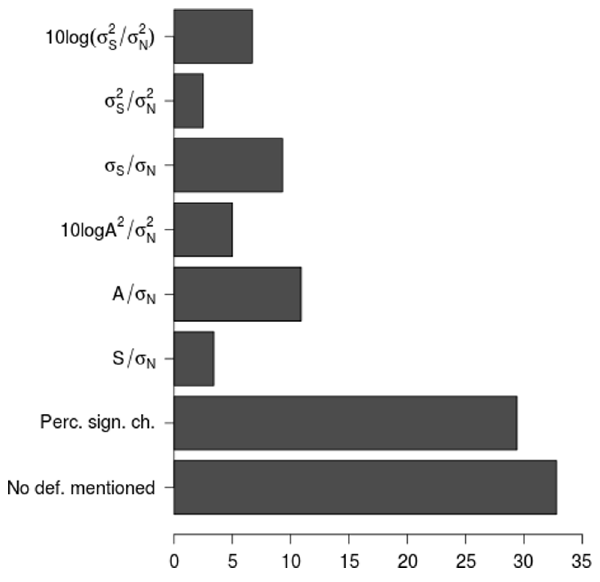
Figure 3. Percentage of the 119 simulation studies from the literature search that reported a specific SNR/CNR definition.